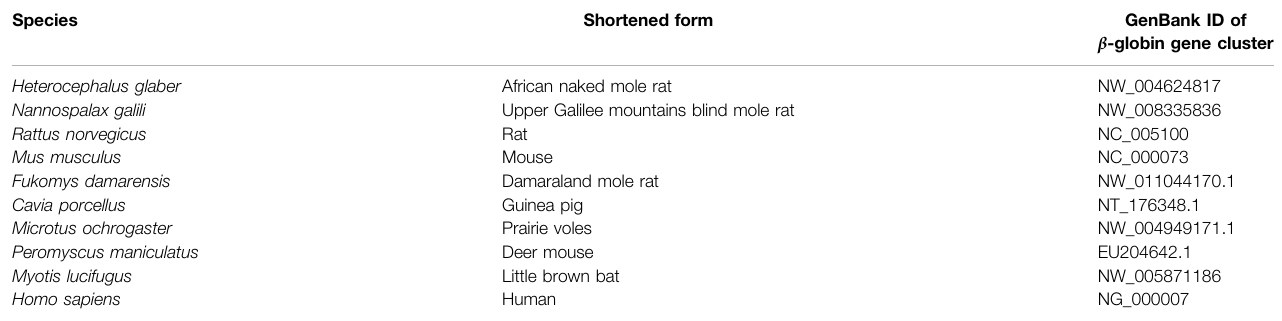
TABLE 1 | Names of 10 kinds of animals and their GenBank IDs of β -globin gene cluster.